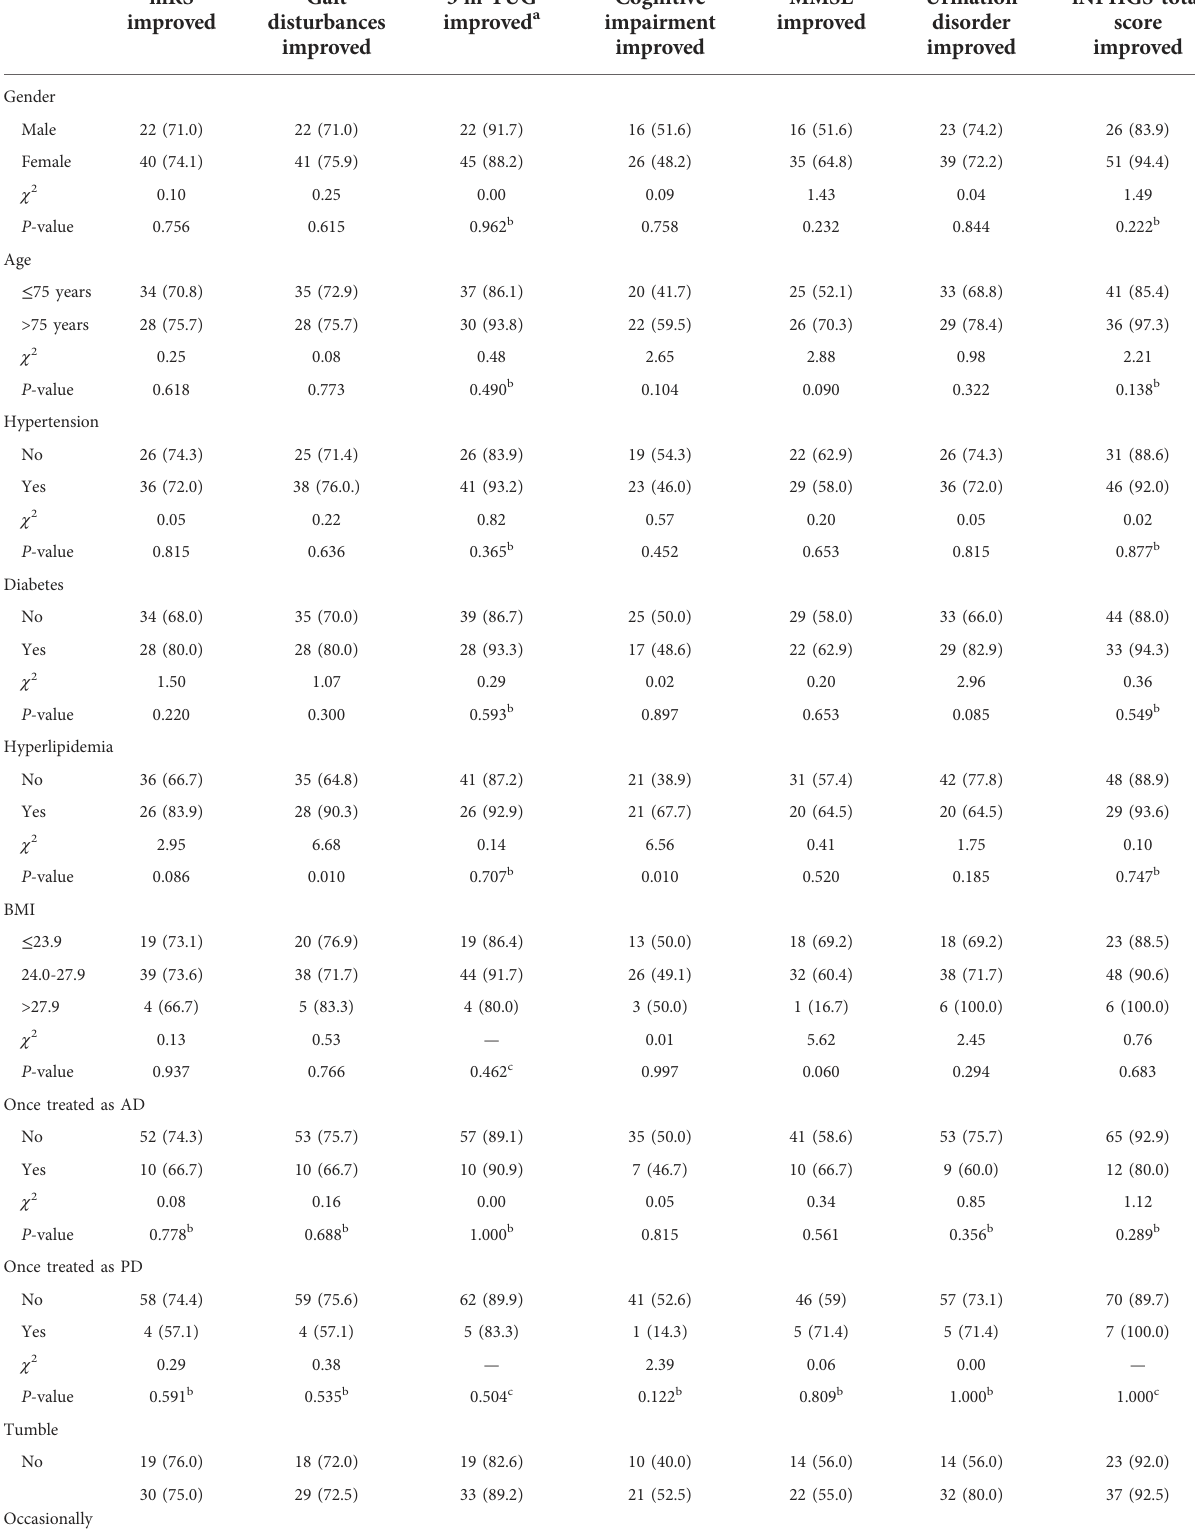
TABLE 4 Functional and symptomatic improvement rates in different subgroups 1 year after operation [ n (%)]. mRS Gait Cognitive 3 m-TUG improved disturbances impairment improved a improved